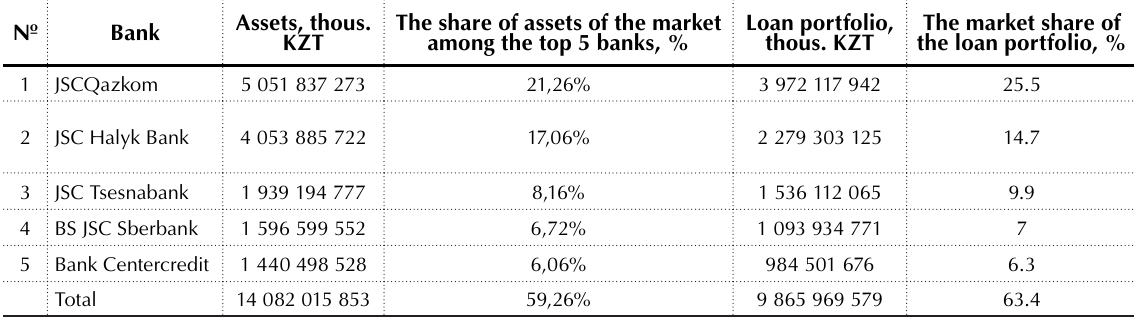
Table 5. Analysis of top 5 banks in terms of assets and loan